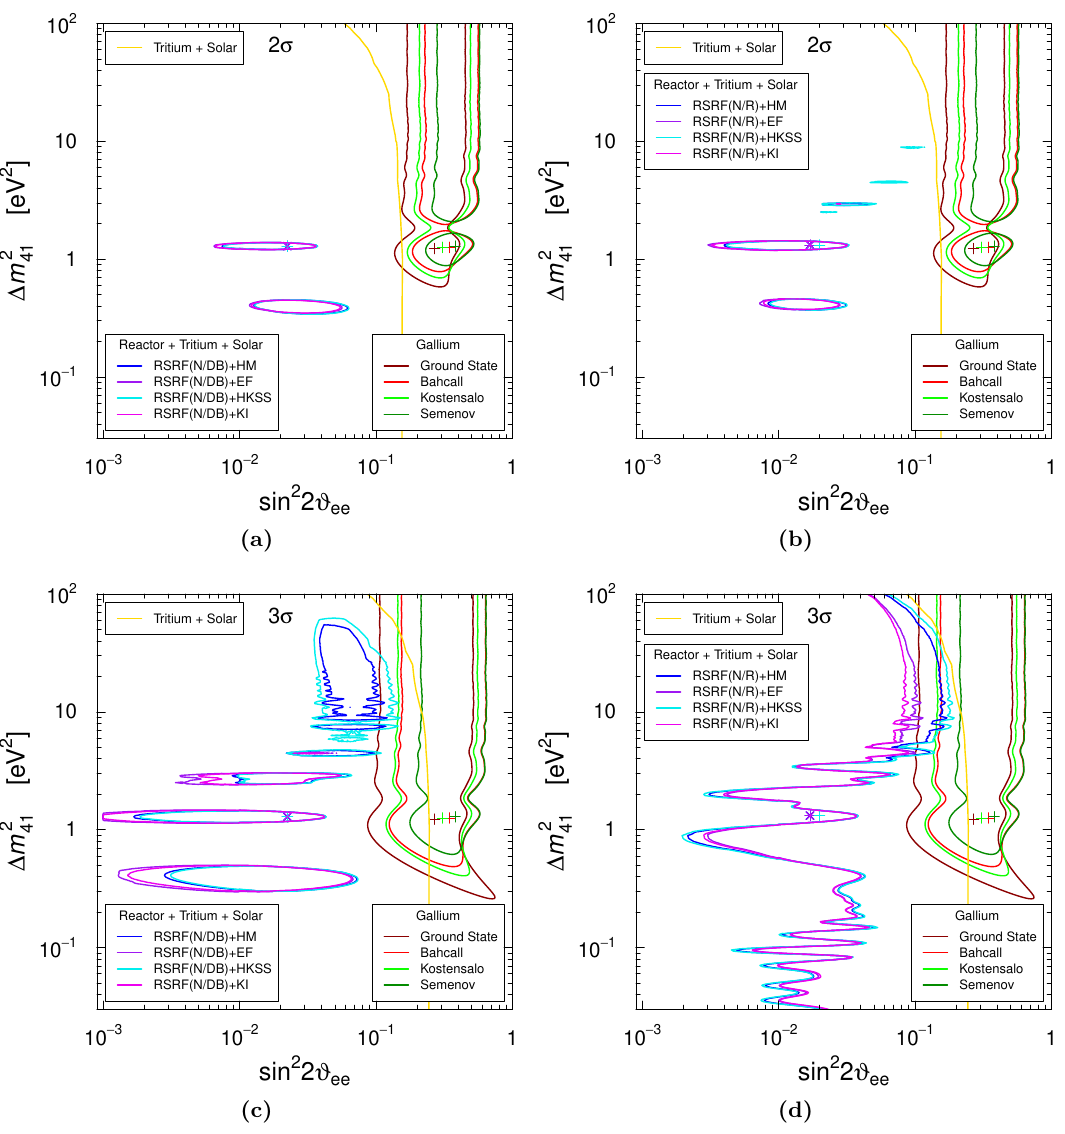
Figure 10. Comparison of the contours delimiting the [(a) and (b)] 2 σ and [(c) and (d)] 3 σ allowed regions in the ( sin 2 2 ϑ ee , ∆ m 2 ) plane obtained from the combined analysis of the data 41 of the reactor rate experiments with different flux models, the spectral ratio experiments,reactor the Tritium experiments, and the solar bound with those obtained from the Gallium data with different cross sections. Also shown is the 3 σ bound obtained from the combination of the Tritium and solar bounds. The figures differ by the use of [(a) and (c)] NEOS/Daya Bay [45] or [(b) and (d)] NEOS/RENO [46] spectral ratio data. The best-fit points are indicated by